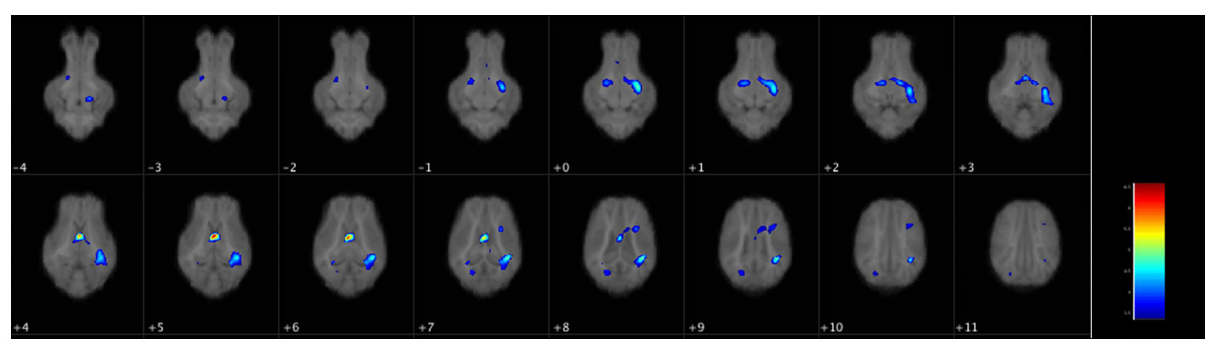
FIGURE 3 | Voxel-based morphometry map of increased white matter clusters in HF piglets compared to CON. Voxel-based morphometry revealed HF fed piglets have more white matter in several key regions compared to CON fed piglets regardless of birth weight. These areas were the next to the lateral ventricle (periventricular white matter), the internal capsule, the left and right cortices, the midbrain, and the hypothalamus. Each image is a 1mm axial slice composite of all piglet brains. The color bar represents the pseudo-T statistic indicating level of significance, with red indicating highest statistical difference between voxels. Values are 6–8 replicate pigs with MRI data collected at 26–29 days of age as described in Table 3 . AGA, appropriate for gestational age; SGA, small for gestational age; CON, control; HF, hydrolyzed fat.